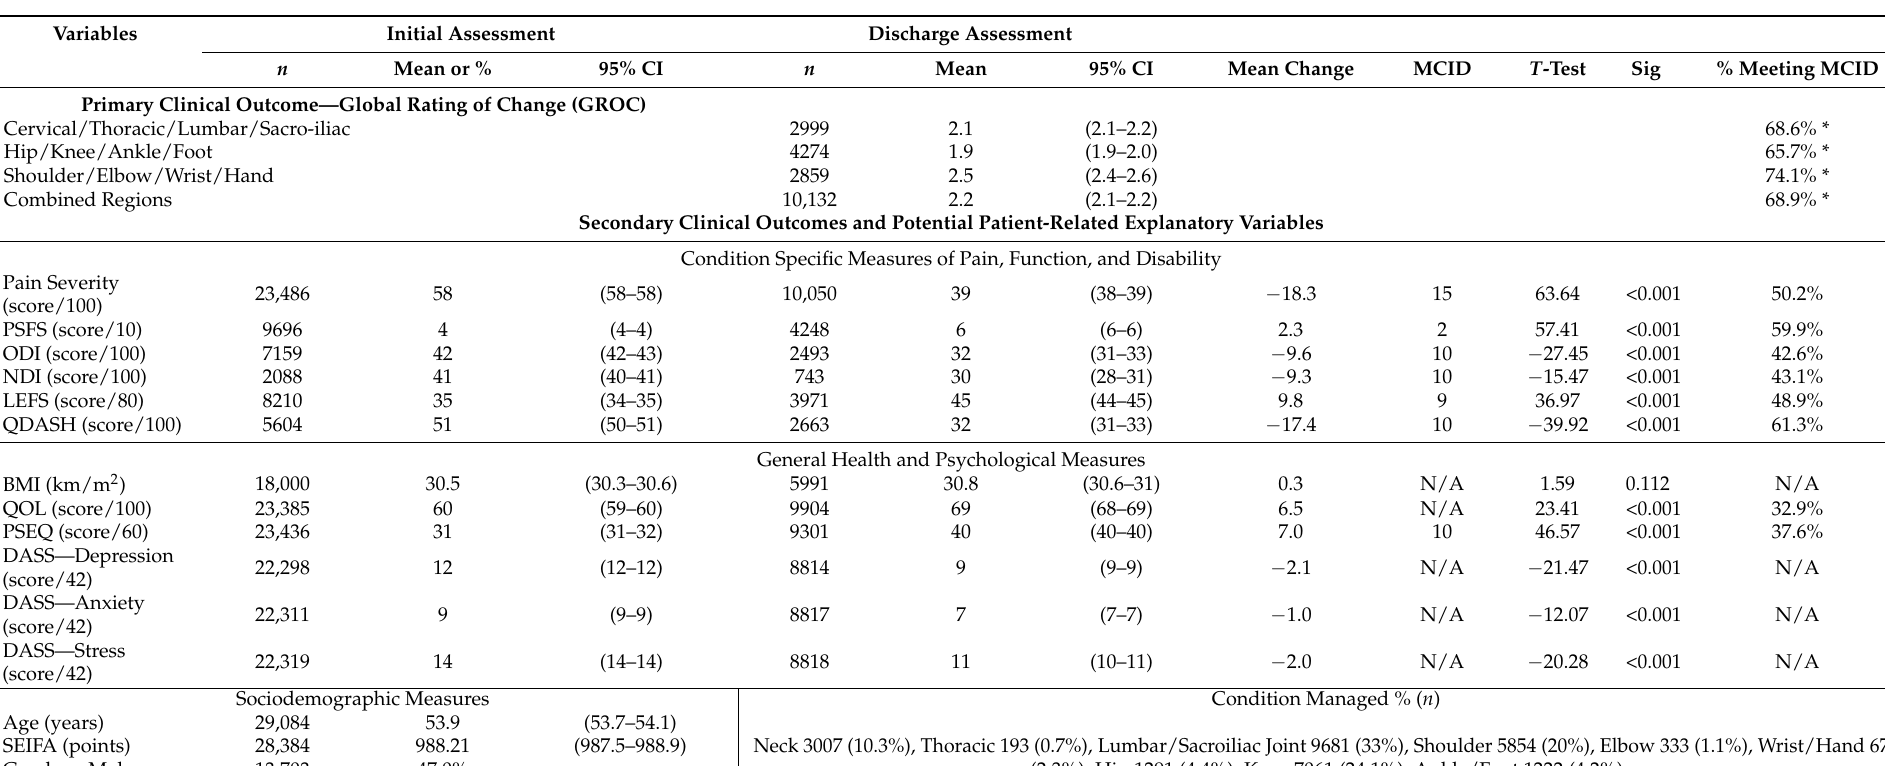
Table 3. Clinical outcomes and potential patient-related explanatory variables recorded at the initial service assessment and at discharge presented as means (95% confidence interval (CI)) or proportions (%), mean change between initial assessment and discharge, and the proportion of cases achieving a Minimal Clinically Important Difference (MCID).